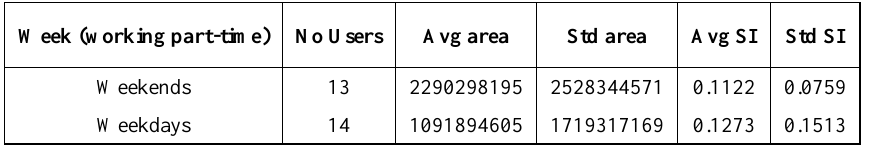
Table 14. Average and standard deviation of area and shape index of part-time job users grouped based on weekdays.